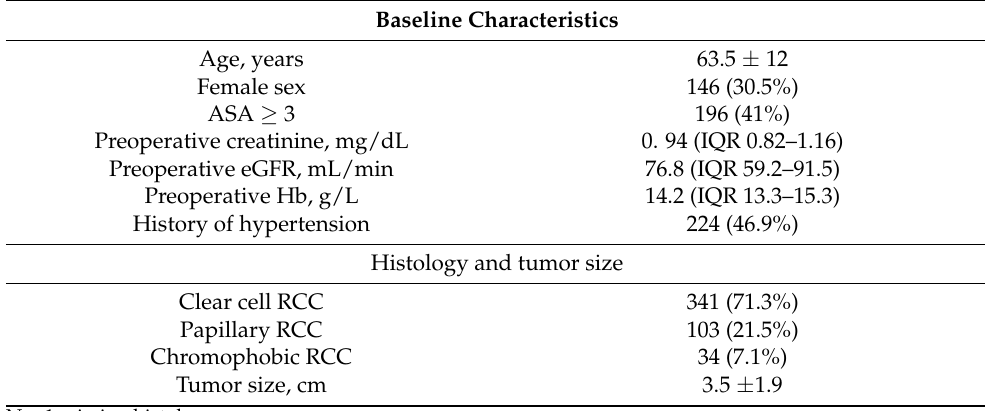
Table 1. Baseline and tumor